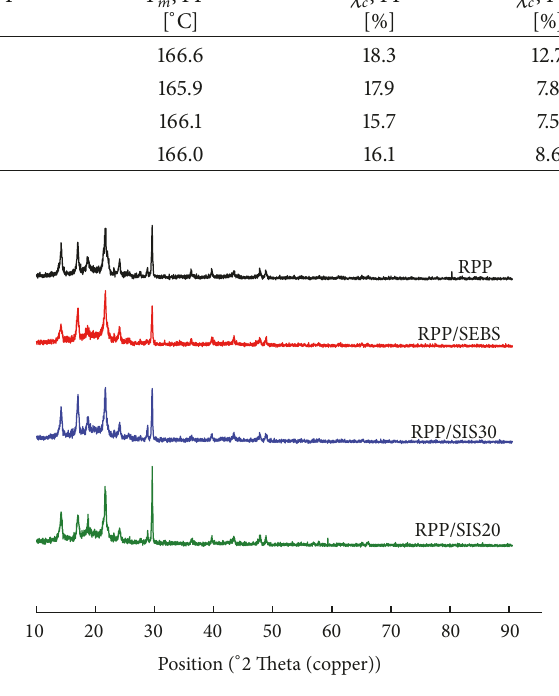
Figure 5: Representative XRD patterns for RPP and RPP/elastomer